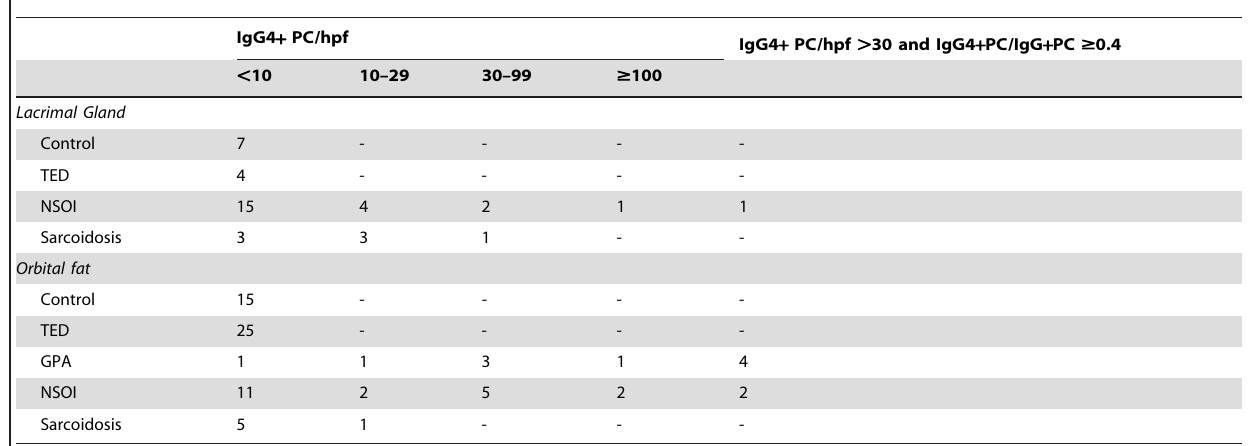
Table 2. A minority of subjects with inflamed orbits have markedly high IgG4 + PC counts.